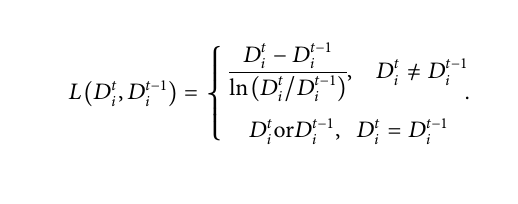
FIGURE 3 | Gravity Center and standard deviation ellipse (SDE) of disaster-induced grain yield loss in China from 1978 to 2019.